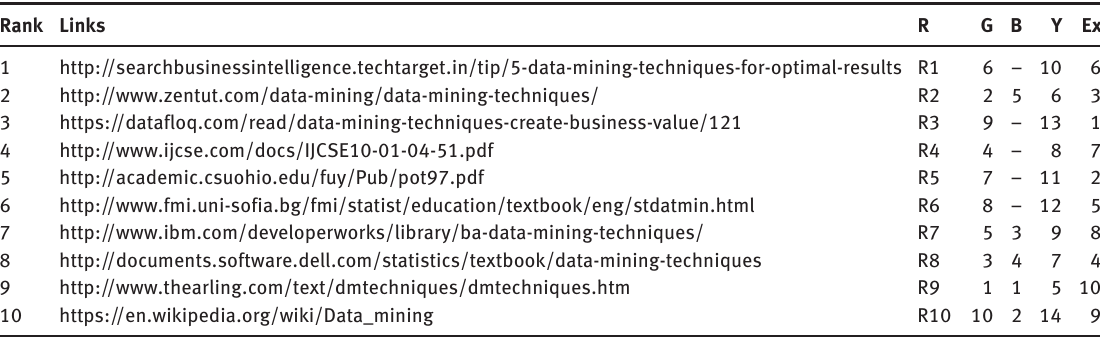
Table 1: Top Lists and Relevant Documents of the Query “Data Mining Techniques.” Rank Links